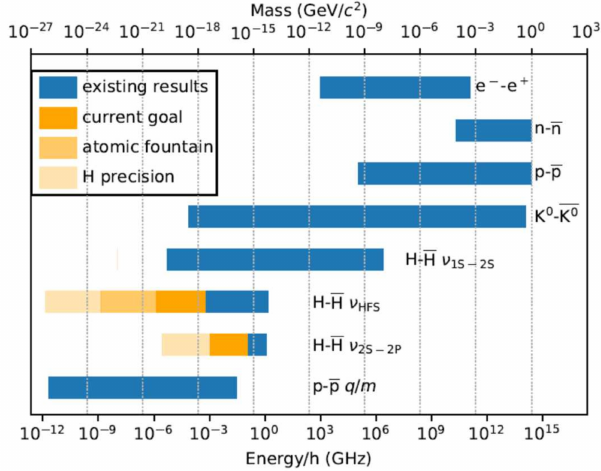
Figure 1. Several CPT tests are compared. Right-hand side of the bar: measured quantity. Length of bar: relative precision of the test. Left-hand side of the bar: sensitivity on an absolute energy scale. Blue: performed measurements. Lightest orange: predicted sensitivity if existing precision on Hydrogen is reached for anti-Hydrogen. Other shades of orange are explained in the inset: they refer to different future stages of experimental development. From [21], with permission from the